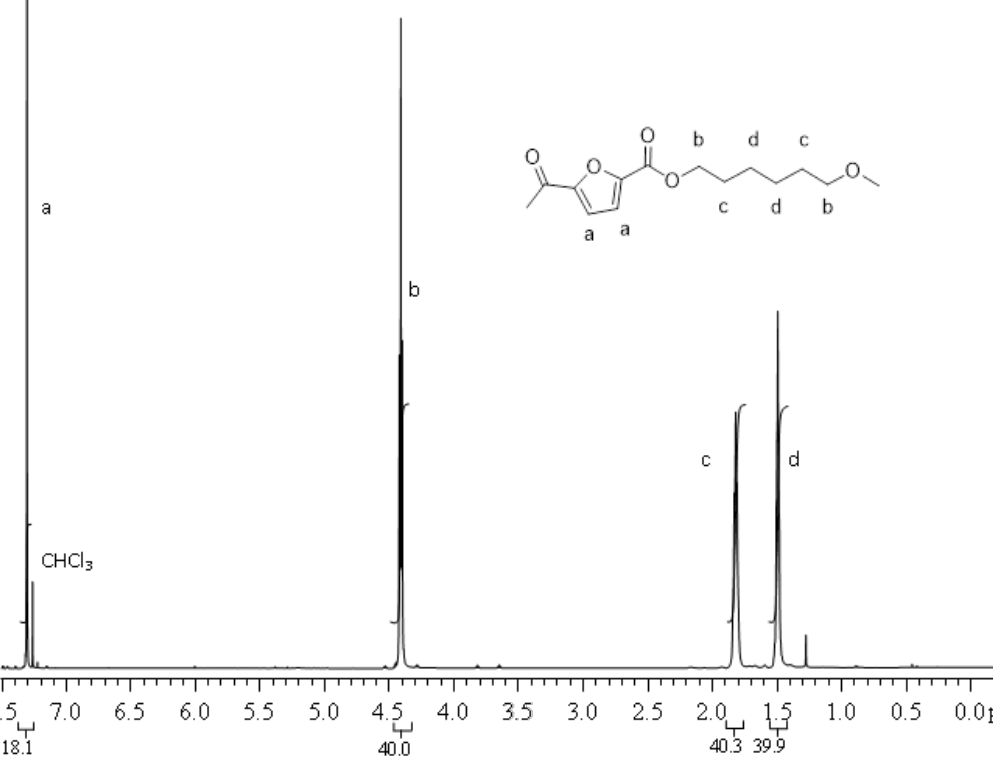
Figure 3. 1 H NMR spectrum of PHF.